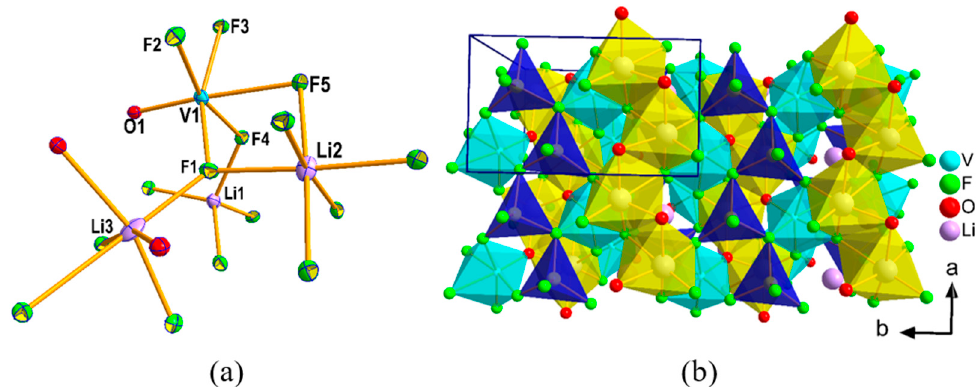
Figure 3. ( a ) Coordination of different atoms in II is shown. Only atoms that appeared in asymmetric unit are labeled. Thermal ellipsoids are given at 50% probability. ( b ) The arrangement of acentric polyhedra, Li(1)F 4 (Blue), Li(3)O 2 F 4 (yellow) and V(1)OF 5 (cyan) are shown to be pointing in same direction.